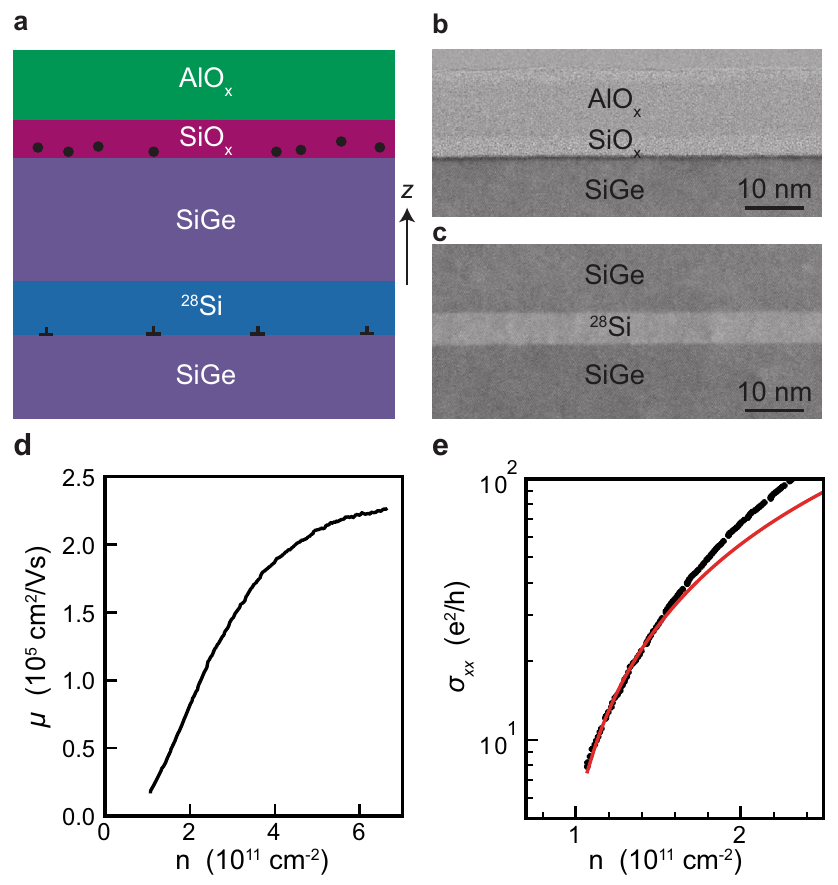
Fig. 1 | Material stack and heterostructure fi eld effect transistor characteriza- tion. a Schematics of the 28 Si/SiGe heterostructure and dielectric stack above. z indicatestheheterostructuregrowthdirection.Circlesrepresentremoteimpurities at the semiconductor/dielectric interface and perpendicular symbols represent mis fi t dislocations that might arise at the quantum well/buffer interface due to